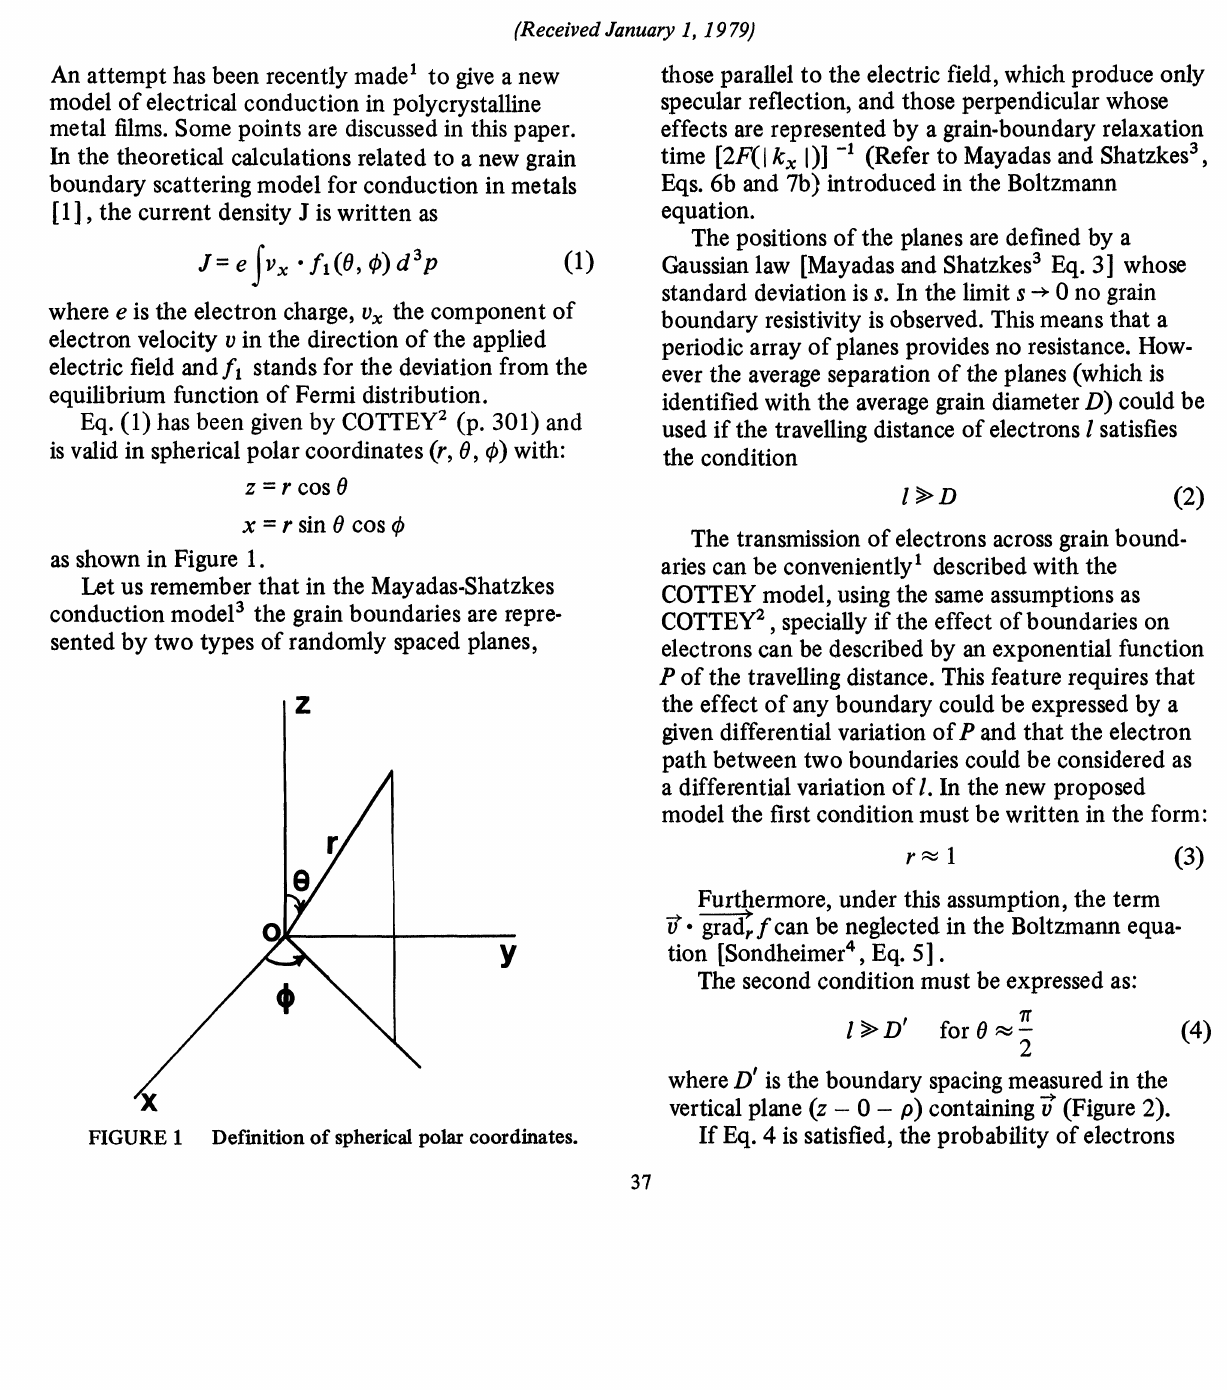
FIGURE 1 Definition of spherical polar